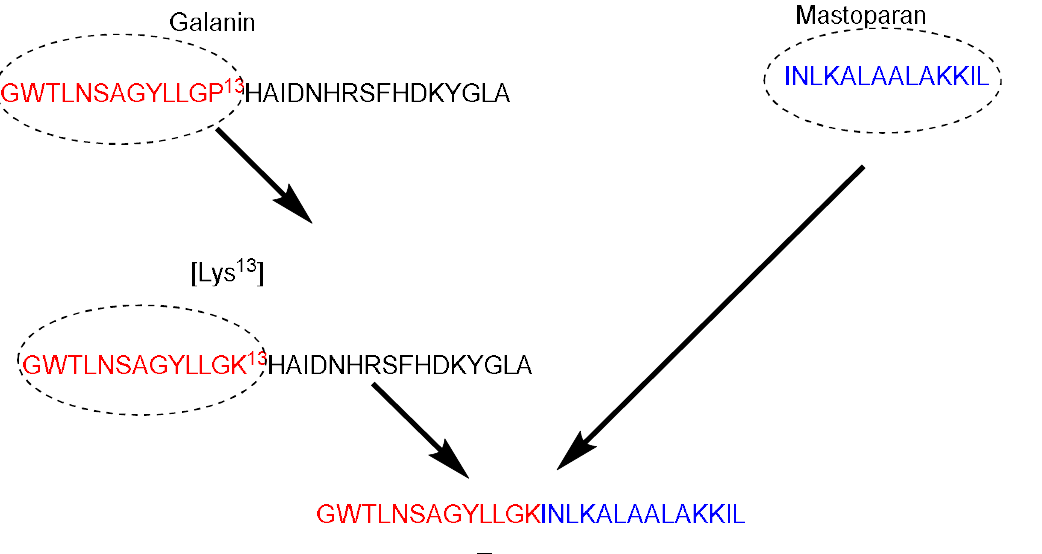
Figure 4. Transportan chimeric peptide sequence. Red: the sequence from galanin neuropeptide; Blue the sequence from the wasp venom peptide toxin (mastoparan).